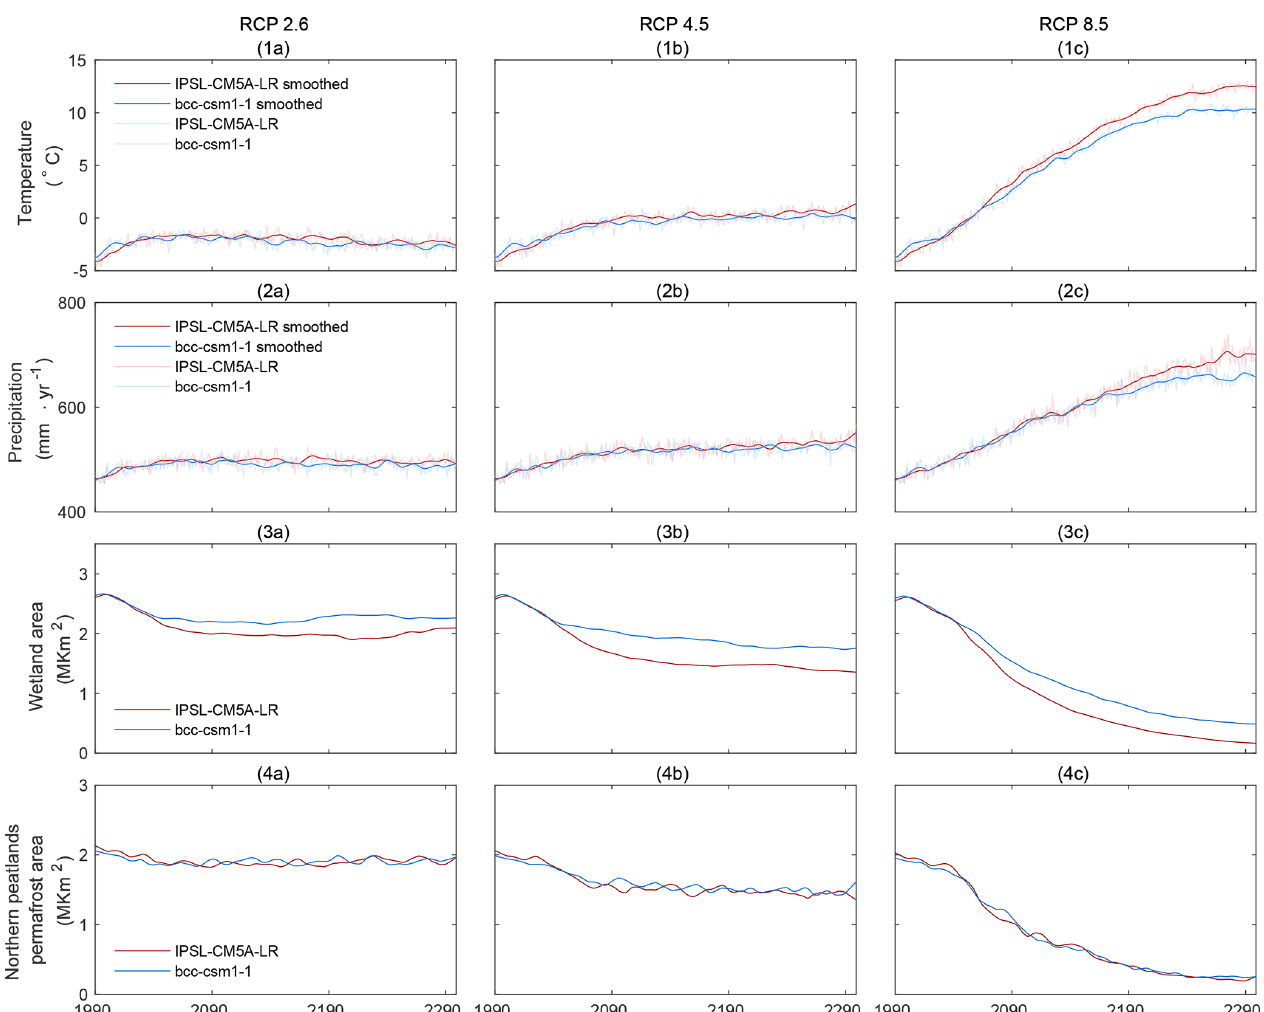
Figure 4. Time series of pan-Arctic annual air temperature ( ◦ C), annual precipitation (mmyr − 1 ), wetland area (Mkm 2 ) and permafrost area in peatland regions (Mkm 2 ) during